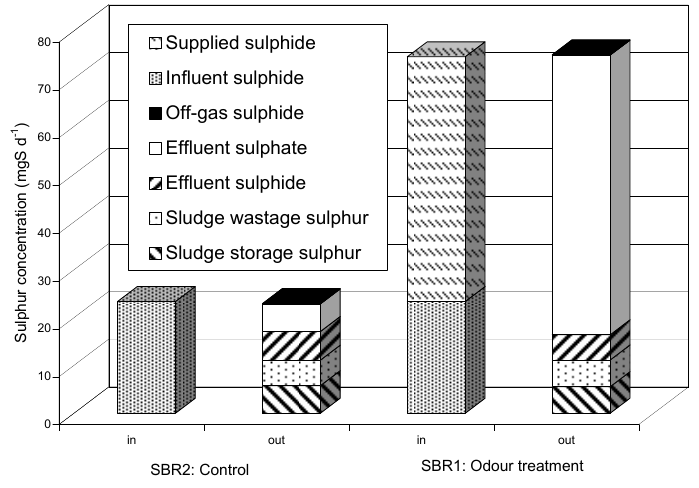
Figure 2. Mass balance of main sulphur compounds during the second